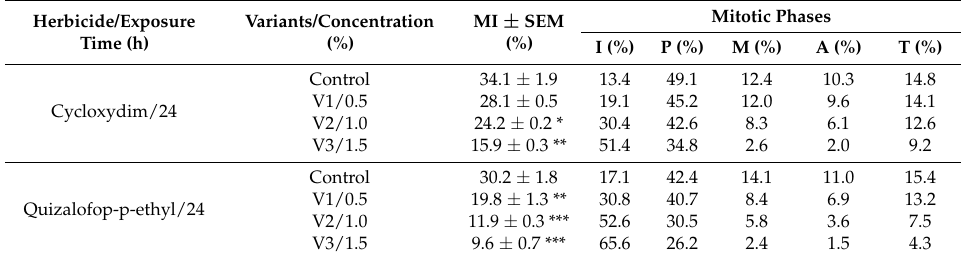
Figure 3. The inhibitory effect of cycloxydim and quizalofop-p-ethyl herbicides on the growth of the Allium cepa roots. Table 1. Mitotic index and mitotic phases of Allium cepa meristematic roots treated with different doses of herbicides.